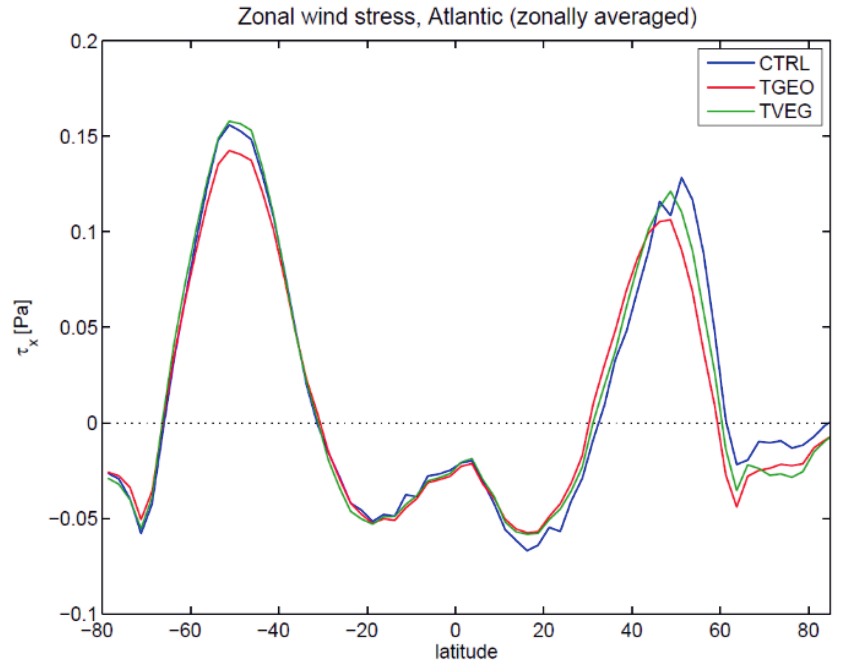
Figure 6. Zonal mean zonal wind stress in the Atlantic Ocean for CTRL, TGEO, and TVEG.